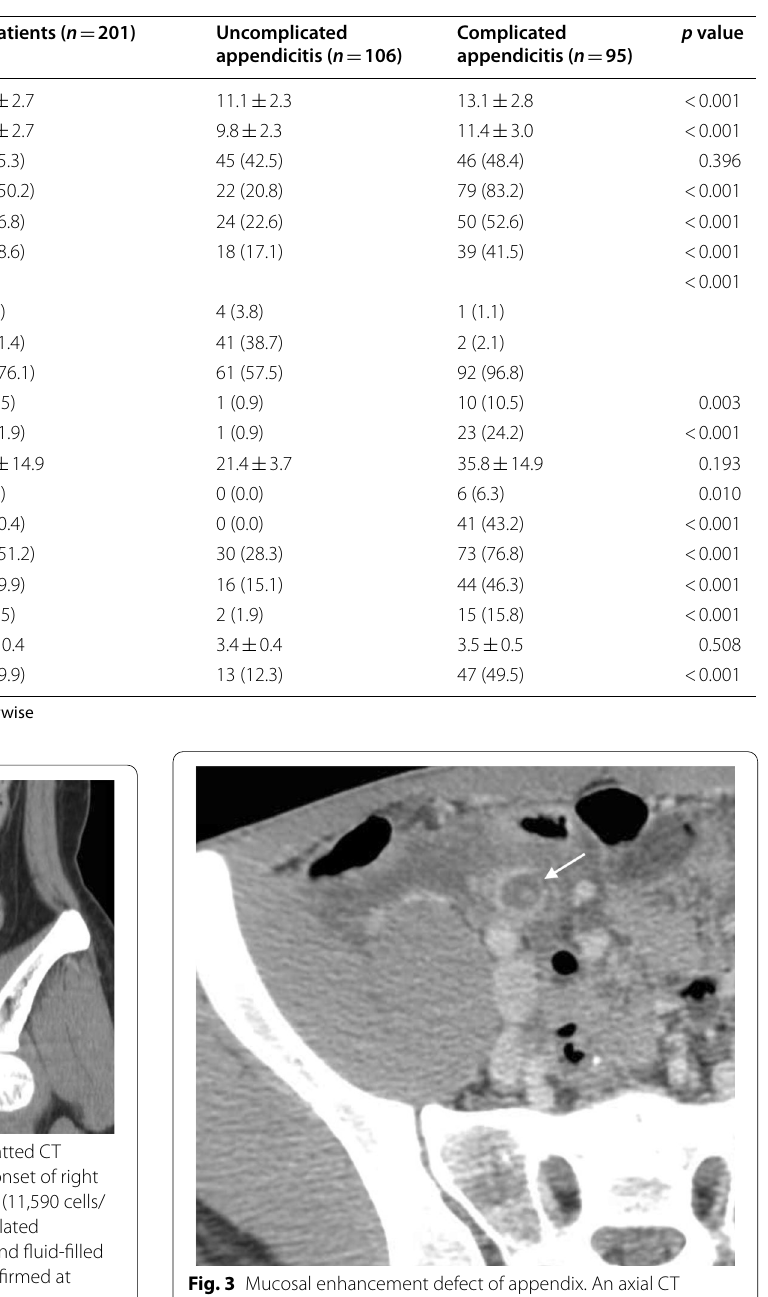
Table 3 CT characteristics